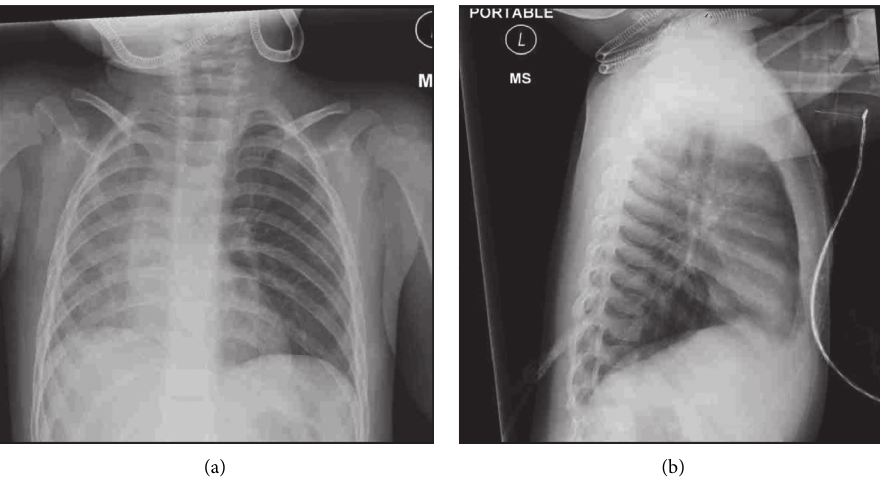
Figure 1: Erect (a) anteroposterior and (b) lateral chest X-rays taken for this patient prior to using the EITdevice. These films were read by the attending pediatric radiologist: “On the lateral view both the lungs appear hyperinflated. There is relative decreased lung volume on the frontal view which is felt to be related to patient rotation.”